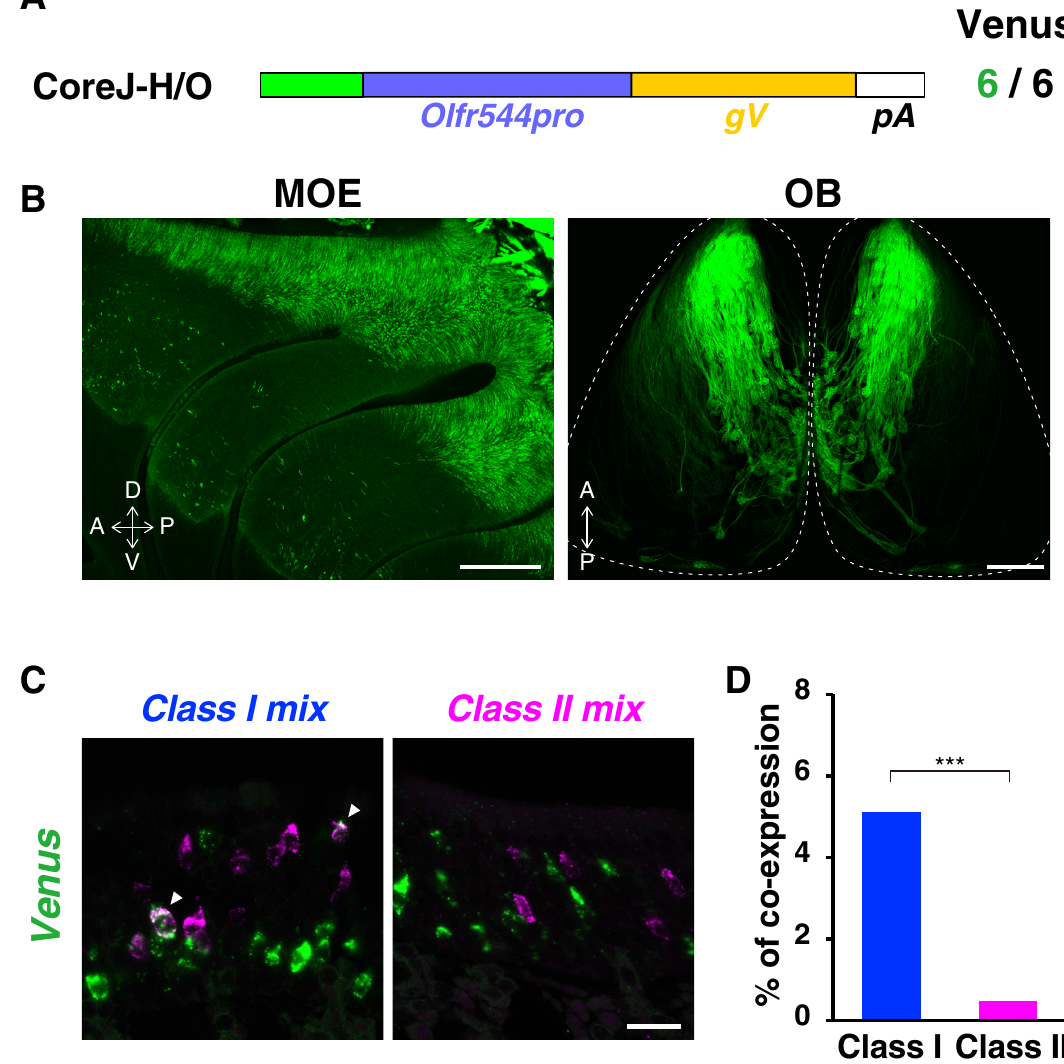
Figure 2. The 330-bp core J-H/O is sufficient for the class I OSN-specific enhancer activity. ( A ) Schematic representation of the CoreJ-H/O transgene construct. The number of gapVenus-positive independent founders out of the total number analyzed is shown on the right. ( B ) Whole-mount fluorescent images of the turbinate of MOE and the dorsal OB of CoreJ-H/O Tg F1 mice (Line#10). The scale bar is 500 μm. ( C ) Confocal images of two color ISH of Venus (green) with mixed probes of class I or class II OR genes (magenta) in CoreJ-H/O Tg mice. Arrowheads indicate the cells co-expressing Venus and OR genes. The scale bar is 20 μm. ( D ) Bar graph showing the percentage of Venus -positive cells that were labeled with the class I or class II OR mixed probes (1058 cells for class I, 1057 cells for class II from three Tg mice). Co-expression preferentially occurred in class I OSNs. Fisher’s exact test; p = 1.1 × 10 –11 , *** p <